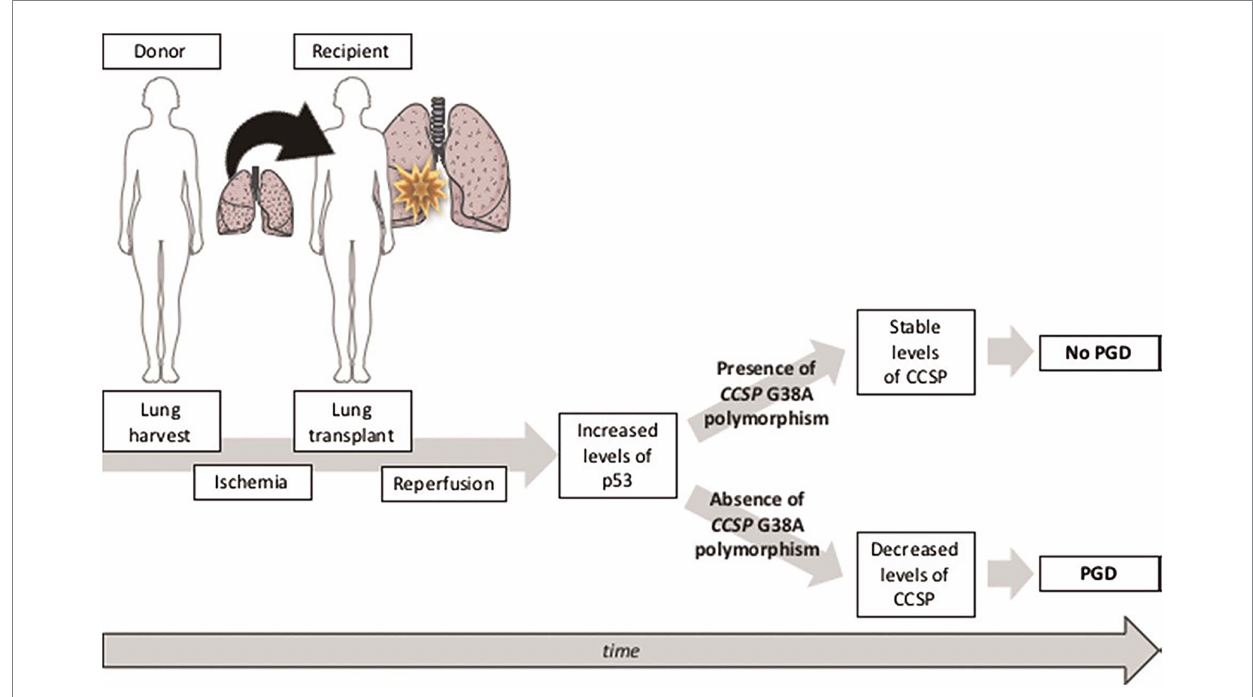
FIGURE 13 Illustration of the hypothesis: in lung grafts with the G allele of CCSP polymorphism, IR causes an increase in p53 associated with an increase in apoptosis and a decrease in the production of CCSP in lung epithelial cells, thus constituting a vicious circle that may lead to PGD. Conversely, in lung grafts with the A allele of CCSP G38A polymorphism, IR-induced p53 increase has no effect on CCSP expression and CCSP levels, adapted from